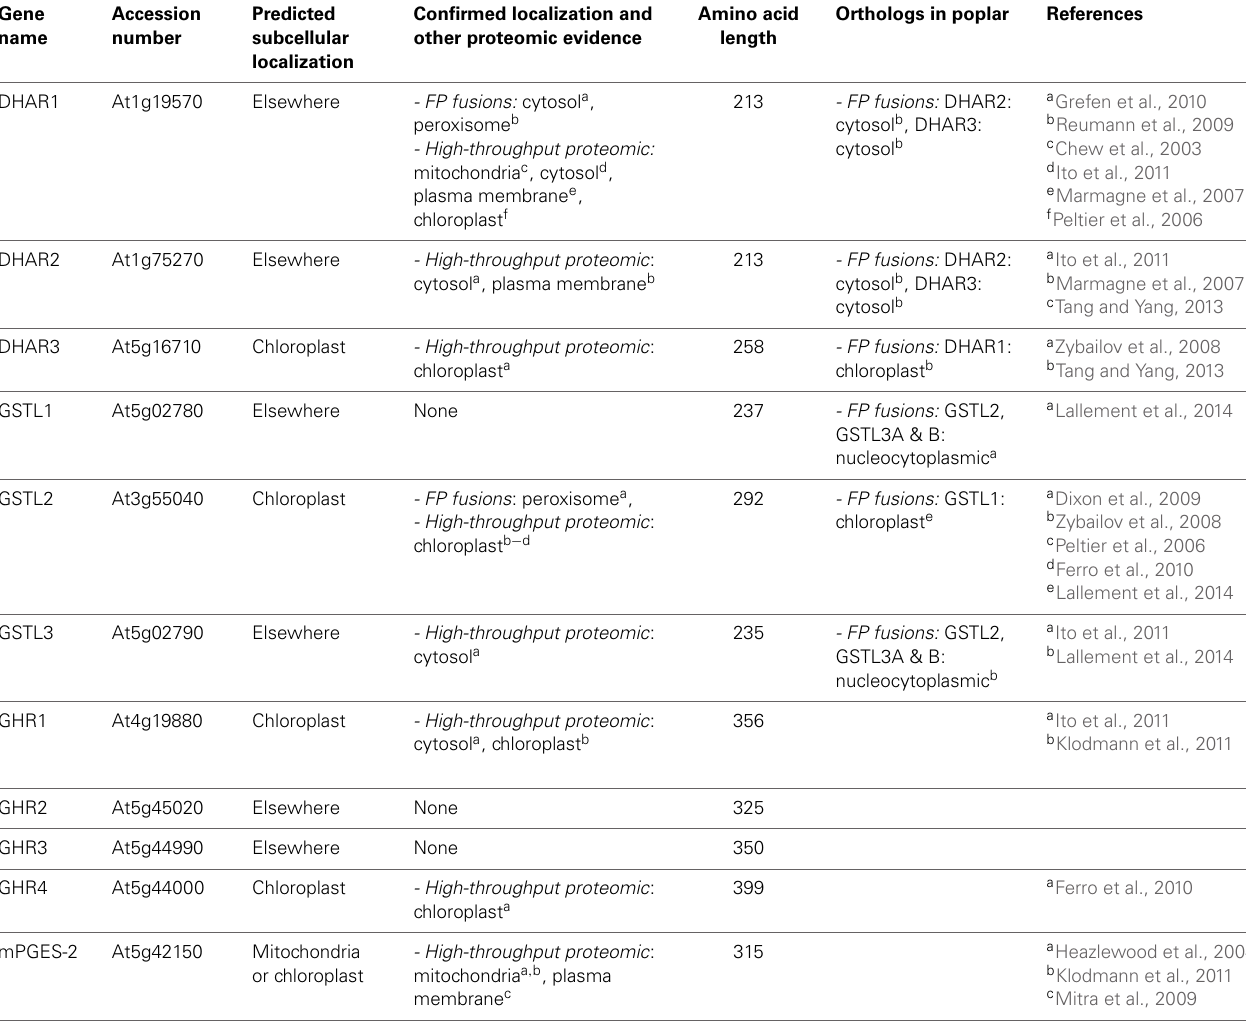
Table 3 | Subcellular localization of Arabidopsis thaliana Cys-GST members and of poplar